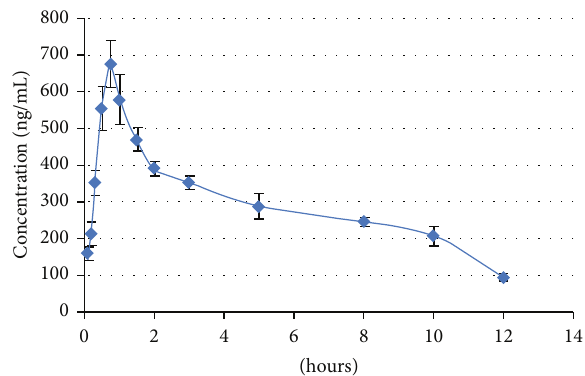
Figure 2: Concentration-time curve for muscone in plasma of rats after a single intragastric administration of artificial musk (625 mg ⋅ kg −1 , 𝑛 = 6